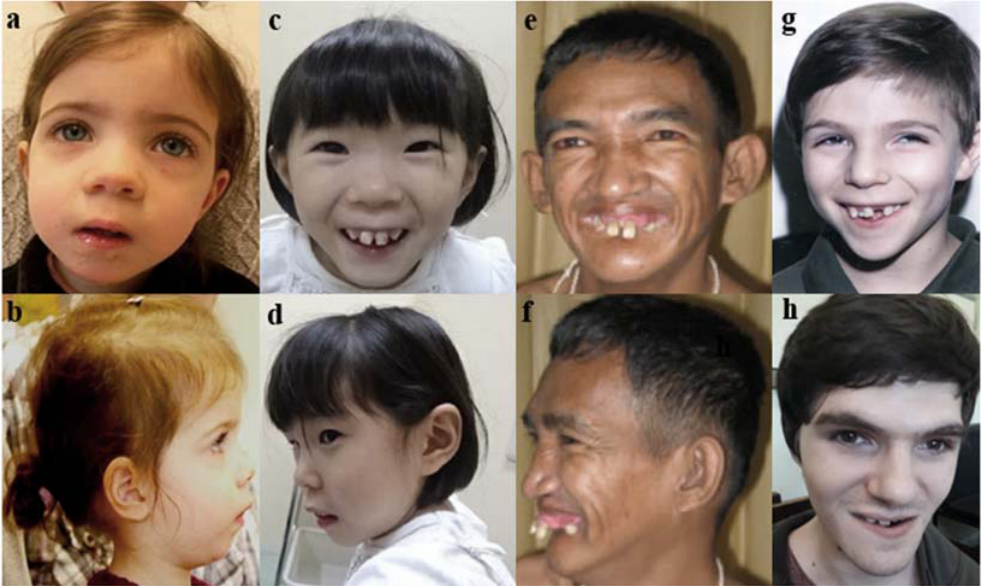
Figure 1. Facial appearance of individuals with c.715C>T (p.Arg239*) variant in SATB2 (( a , b ): Docker et al., 2014 [6]; ( c , d ): Yamada et al., 2019 [25]; ( e , f ): Leoyklang et al., 2007 [5]); and the proband ( g , h ). Note the triangular-shaped face, high anterior hairline, deep-set eyes, mild synophrys, thin vermillion of the upper lip, flat and long philtrum, dental crowding with prominent upper front incisors and prognathism.